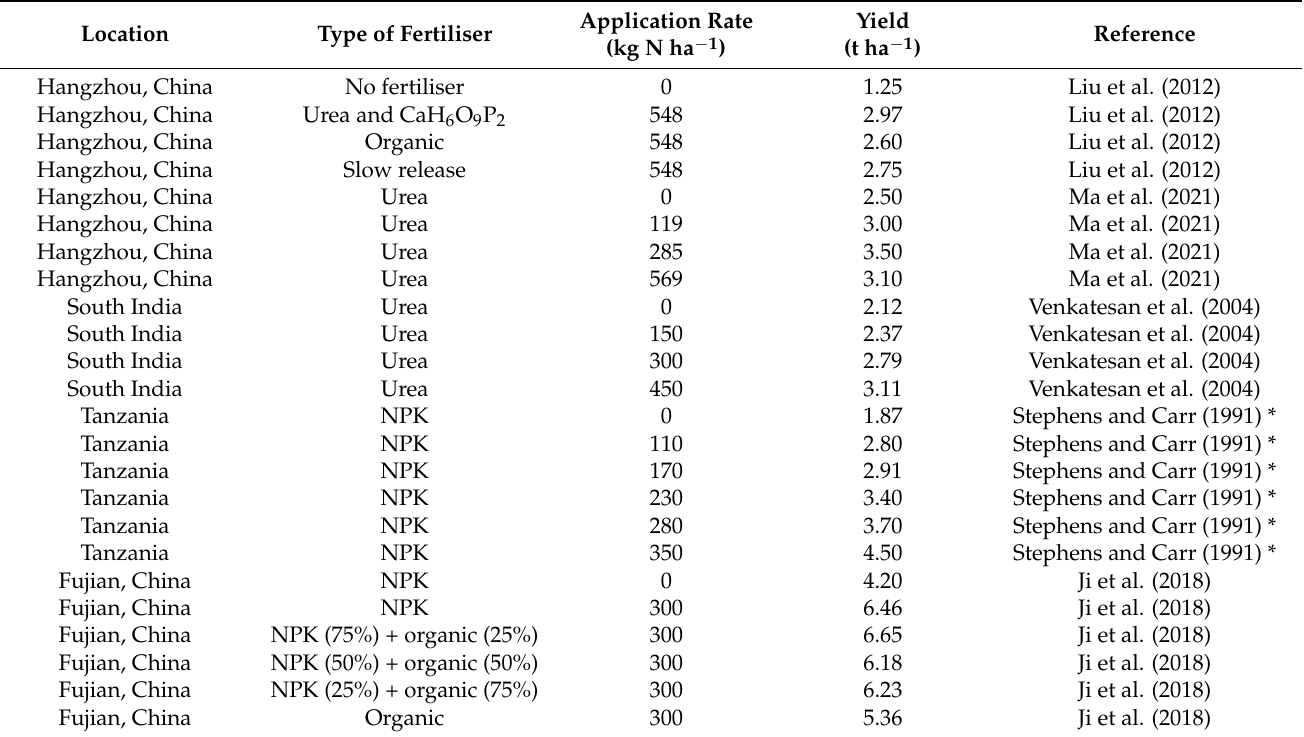
Table 1. Comparative studies of application rates of fertilisers and impacts on yields in tea plantations. * Data from Stephens and Carr (1991) is reported for optimized irrigation